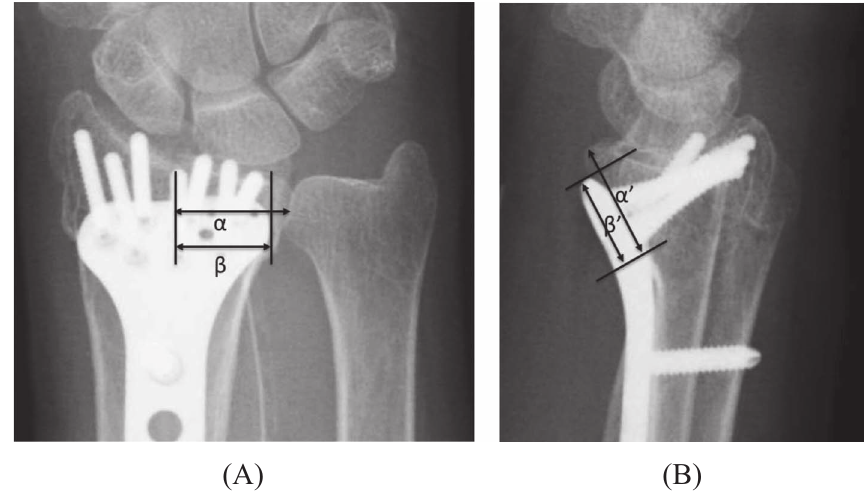
Figure 2. Plate coverage against the transverse dimension of the VLF was calculated as the percentage of the area covered by the plate in the transverse dimension of the VLF on AP radiographs ( b / a ) (2A). In the same way, plate coverage against the longitudinal dimension of the VLF was calculated as the percentage of the area covered by plate in the longitudinal dimension of the VLF on lateral radiographs ( b ’ / a ’ ) (2B). Table 3. Multivariate analysis of the plate coverage rate for VLF. p value Odds ratio 95% con fi dence interval Plate coverage against the transverse dimension of the VLF 0.132 0.877 0.74 – 1.04 Plate coverage against the longitudinal dimension of the VLF 0.029*